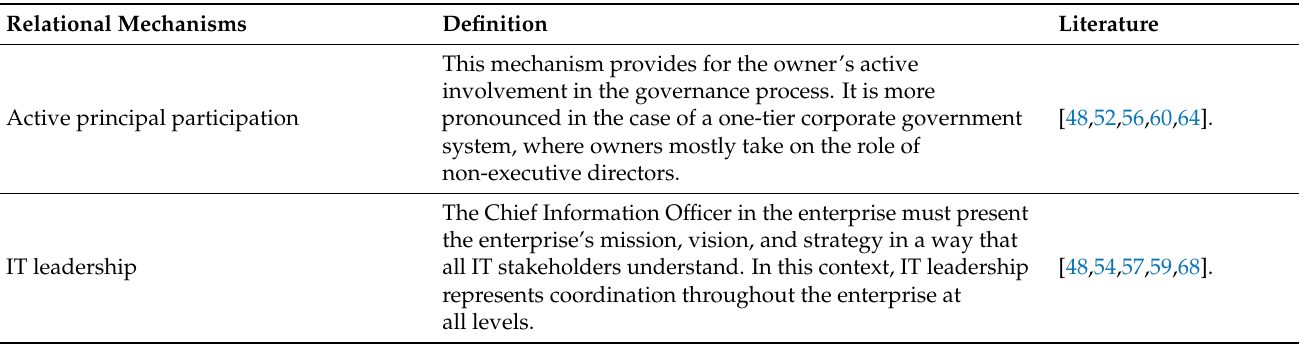
Table 3. Strategic ITG relational